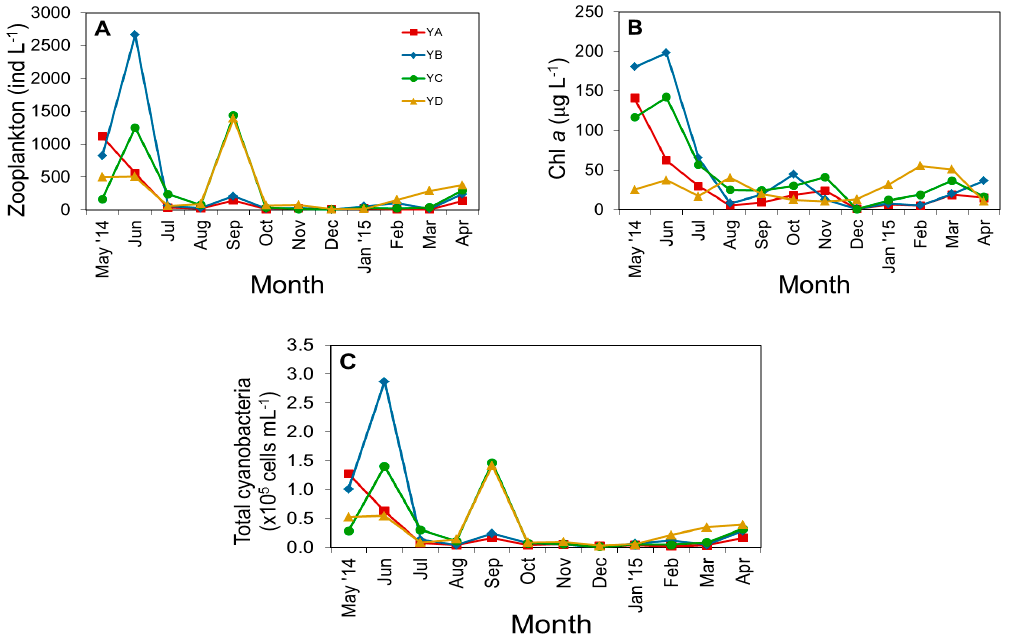
Figure 5. Monthly and spatial variations of biological variables: ( A ) zooplankton abundance, ( B ) chlorophyll a , and ( C ) total cyanobacterial count at stations YA, YB, YC and YD in the upper Youngsan River estuary.